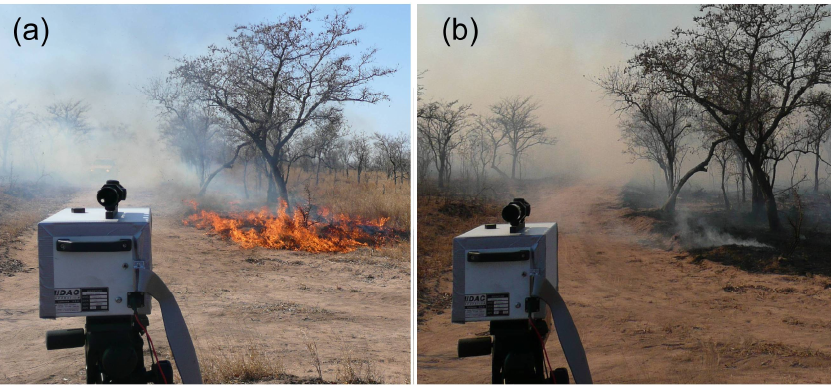
Fig. 3. Photography of the OP-FTIR deployment in Kruger National Park, looking from the FTIR spectrometer towards the IR source. Matching the geometry shown in Fig. 1, the spectrometer is located at the south-west corner of the plot and views northwards, targeting the IR source located 150 m or more away along the western plot edge. (a) Shows the situation shortly after backfire ignition, and (b) towards the end of the residual smouldering combustion (RSC) stage. Smoke is driven by the predominately westerly wind through the long optical path between the spectrometer and IR source. The source cannot be seen visually in these optical wavelength images due to scattering and obscuration by sub-micron sized smoke particulates, though this did not significantly impact the total energy signal recorded by the IR spectrometer (which measures at wavelengths > 2.5µm). Note the almost complete replacement of the grass fuel by char and ash in (b) , but the apparently very limited fire impact on the larger trees.